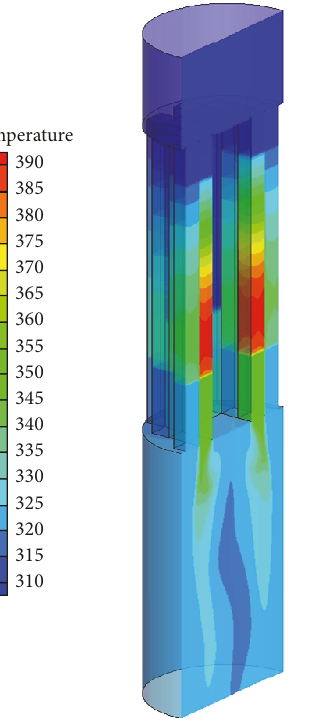
Figure 10: Flow distribution inside each assembly for an inlet mass flow rate of 300 kg/s.